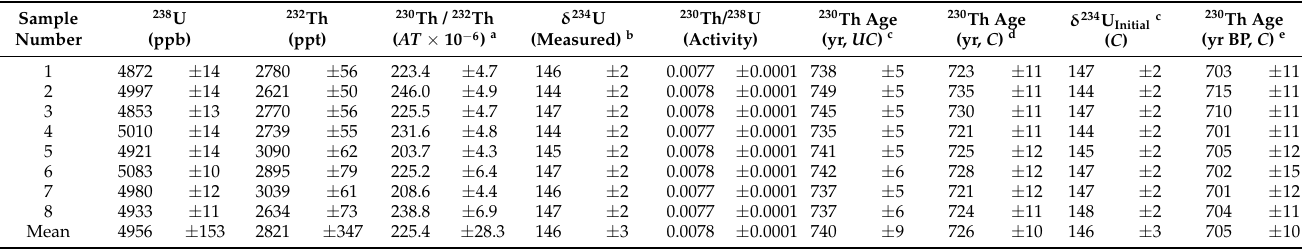
Table 7. U-Th contents and isotopic ratios for sulfide QS-1 ( ± 2 σ , absolute value).